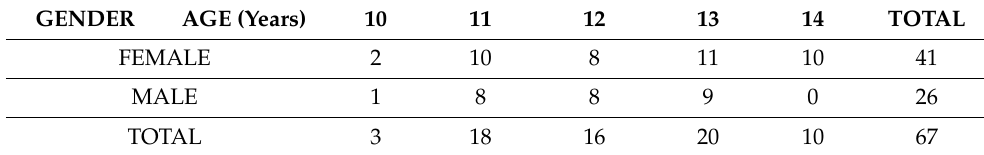
Table 1. Distribution of the students according to age and gender.